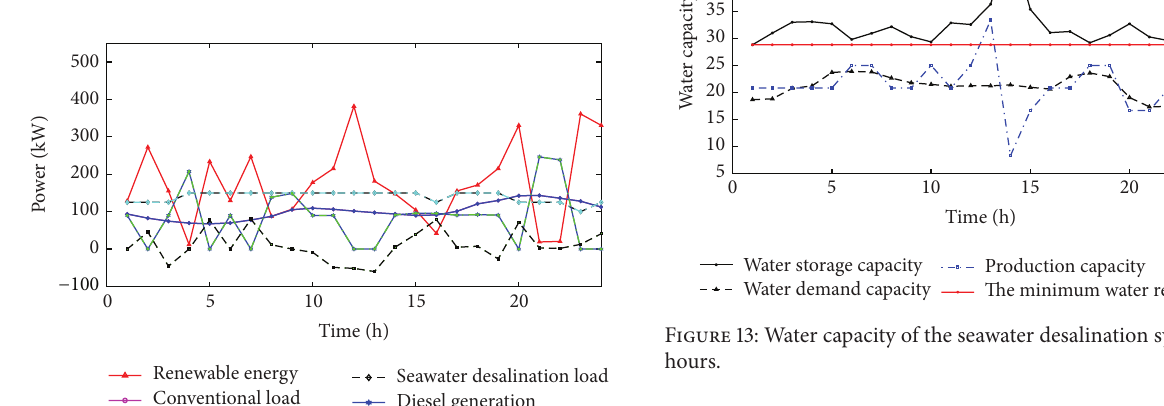
Figure 10: The output results of the various microsources in 24 hours without auxiliary power regulation at the least total loss expenses conditions.